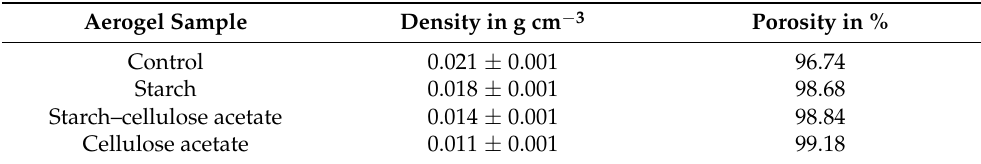
Table 2. Densities and calculated porosities of the aerogel